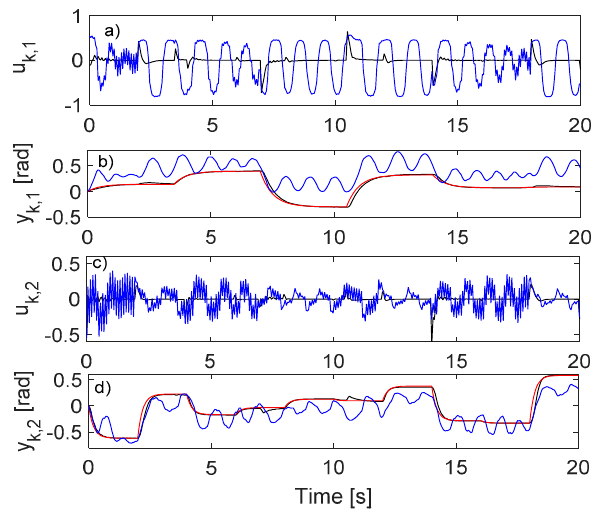
Figure 12. VSFRT (black lines) and AI-VIRL (blue lines) learned from open-loop data, tested in